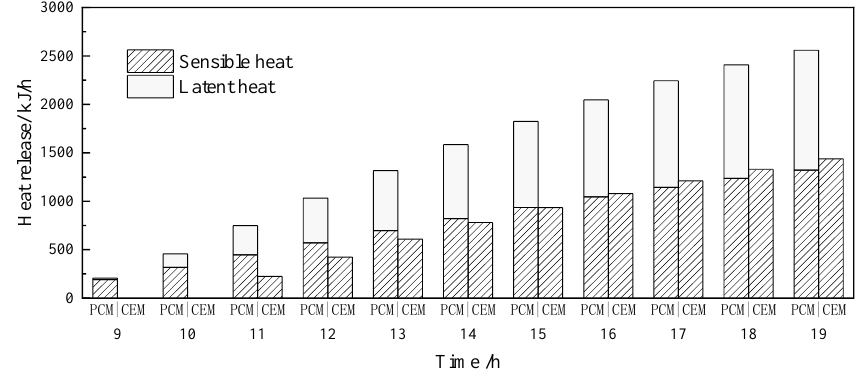
Figure 18. Variation in heat release of the wallboards with time.